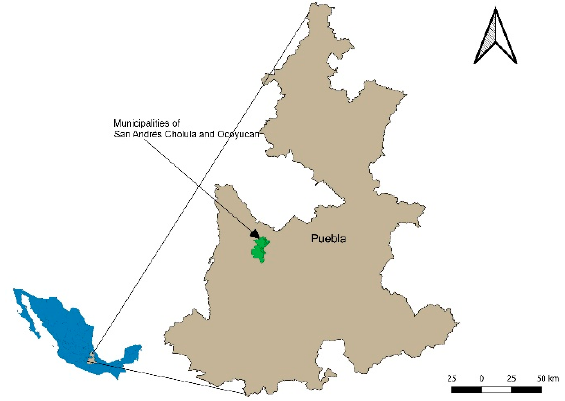
Figure 1. Locations of the case study areas in Figure 1 . Locations of the case study areas in Mexico.